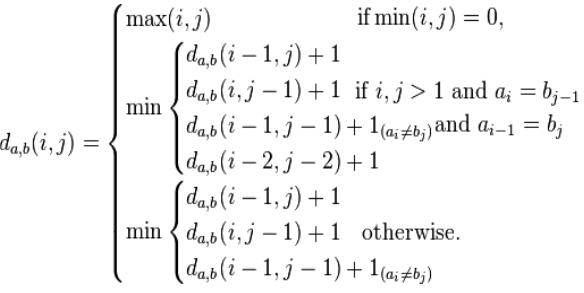
Figure 5 . Damerau-Levenshtein Distance Formula To calculate this distance, it suffices to slightly modify the regular Levenshtein algorithm as follows: hold not two, but the last three rows, and add an appropriate additional condition - in the case of transposition take into account its cost.